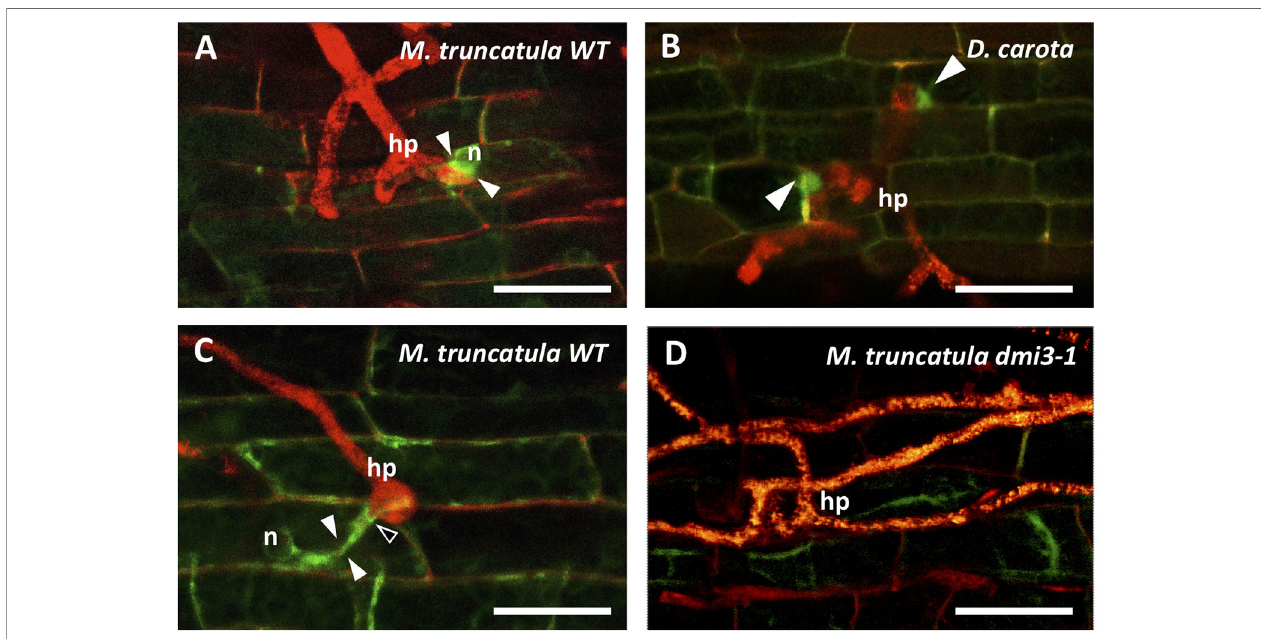
FIGURE 1 | Accumulation of TPLATE-GFP in the prepenetration apparatus of Medicago truncatula and Daucus carota root epidermal cells. In the presence of a hyphopodium (hp) on the root surface of M. truncatula WT ROCs (A , C) and D. carota ROCs (B) , intense TPLATE-GFP fl uorescence is observed in the PPA area (arrowheads), during the initial nuclear repositioning (n) (A) , at two sites of fungal contact within the same hyphopodium (B) and during the following extension of the PPA (C) . Furthermore, a thin line of intense fl uorescence is also visible in C, outlining the point (empty arrowhead) where the penetrating hypha is developing. In contrast, no GFP accumulation is visible on the root surface at the hyphopodium contact site of M. truncatula dmi3-1 mutants (D) that are impaired in PPA formation and fungal colonization. Bars = 50